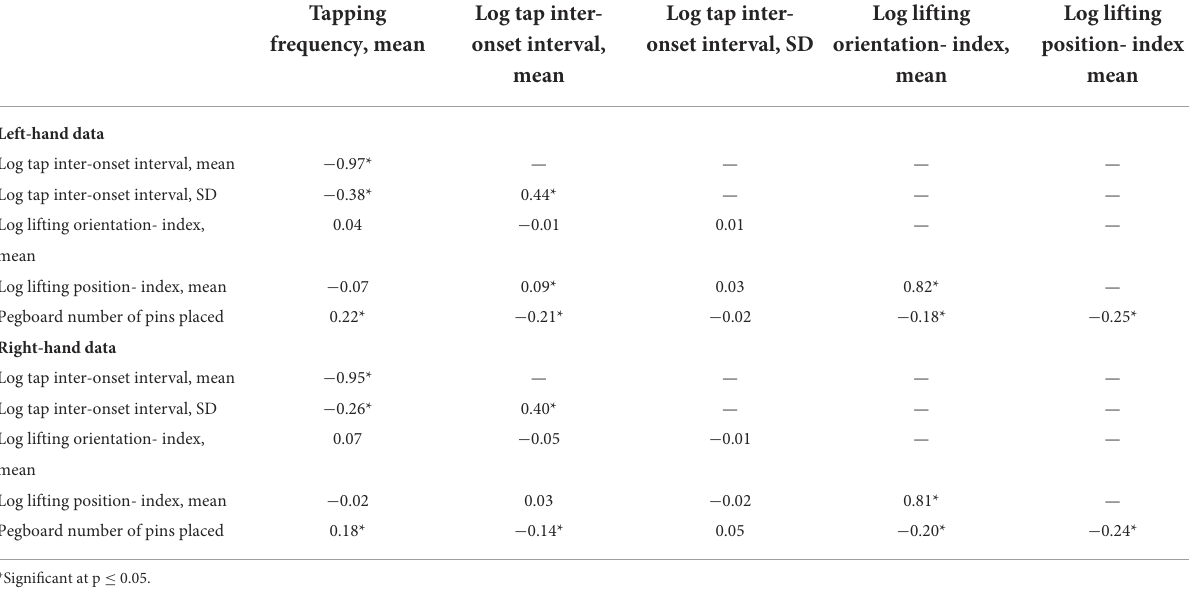
TABLE 5 Correlations between Q-Motor and Pegboard outcomes for the right-handed participants, stratified by task-performing hand.